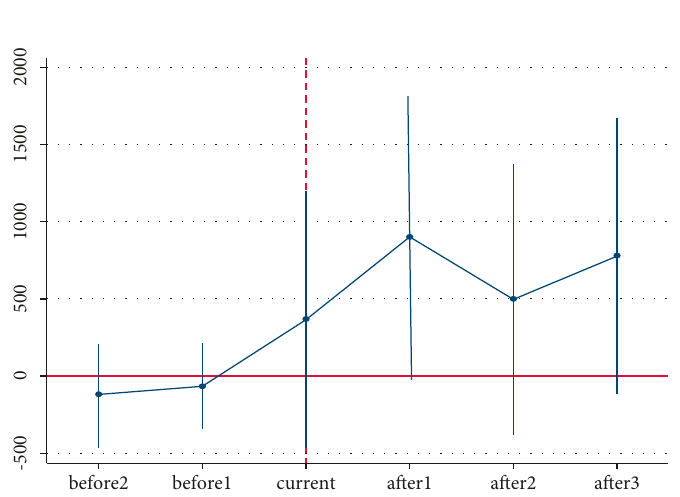
Figure 4: Parallel trends in inbound tourism revenue.